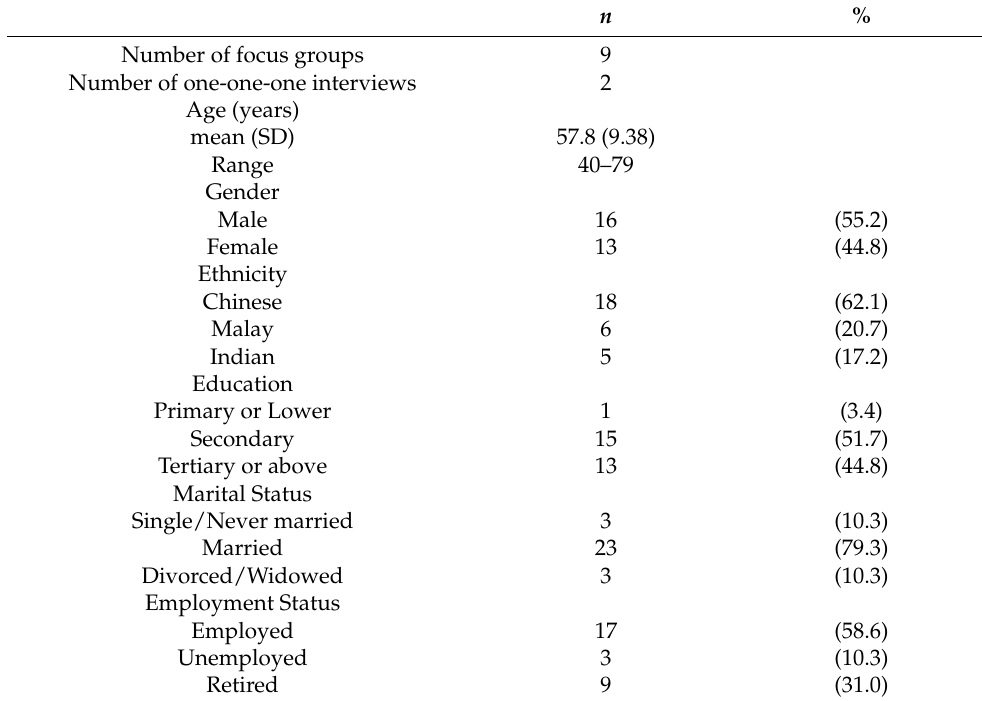
Table 1. Participant characteristics ( n = 29).